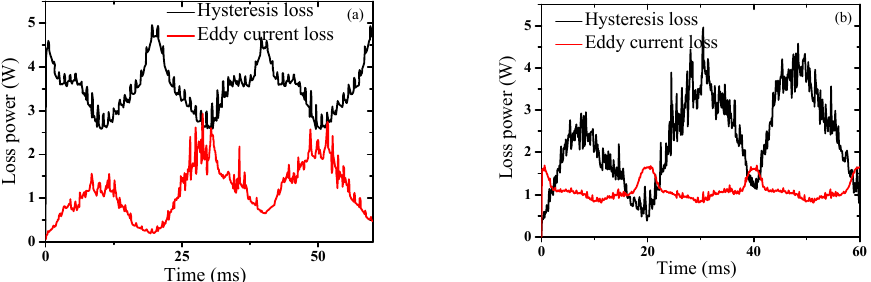
Figure 11. Eddy current loss and hysteresis loss in the inner ring of the Nest-Rot-SPM at different temperatures: 188.1 °C ( a ) and 158.5 °C ( b ).